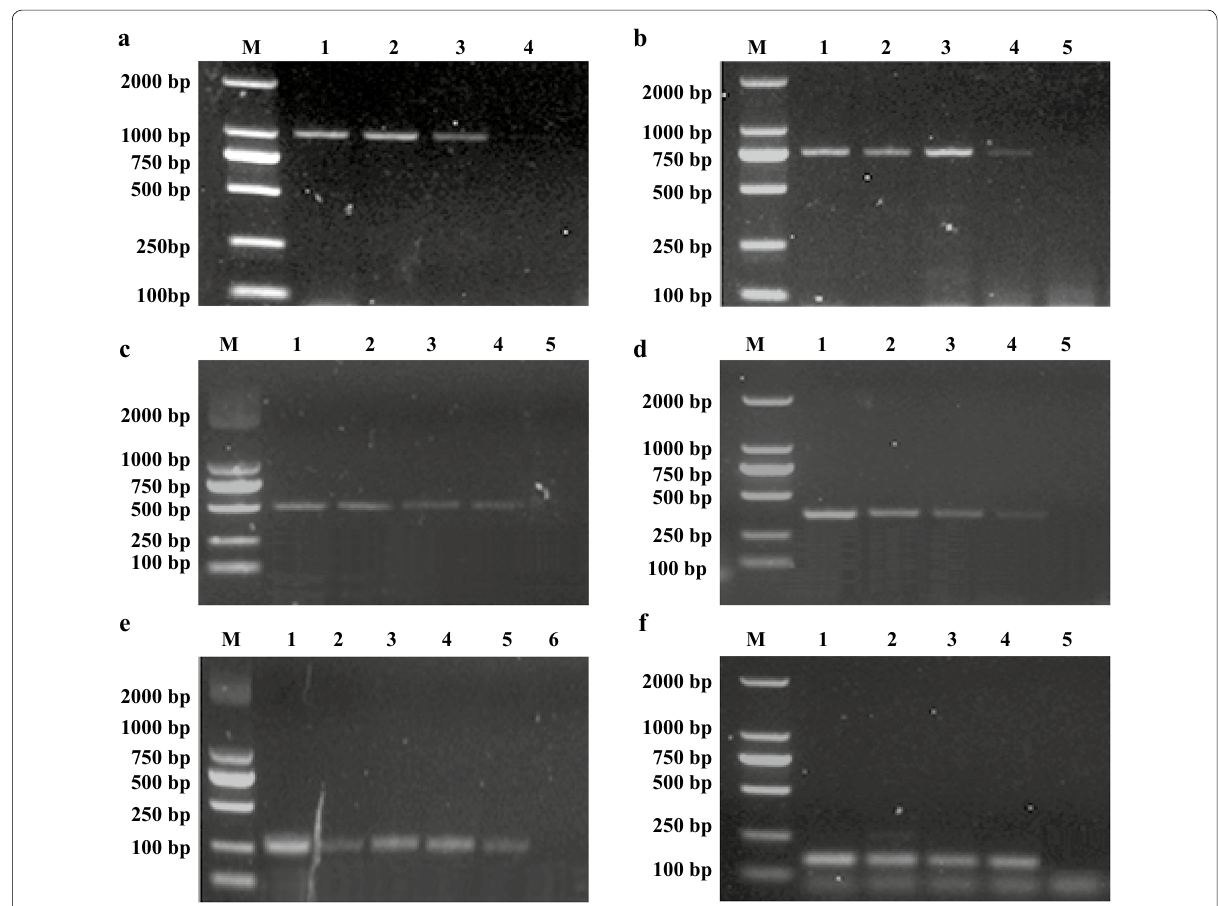
Fig. 6 Determination of the sensitivity of the m-PCR for bacterial CFU detection. Lane M: 2000 bp DNA Marker. a Lanes 1–4: the template of Escherichia coli respectively were 5 10 5 , 5 10 4 , 5 10 3 and 5 10 2 CFU, respectively. b Lanes 1–5: the template of Pasteurella multocid a × × × × respectively were 6 10 6 , 6 10 5 , 6 10 4 , 6 10 3 and 6 10 2 CFU, respectively. c Lanes 1–5: the template of Proteus mirabilis respectively were × × × × × 2.8 10 6 , 2.8 10 5 , 2.8 10 4 , 2.8 10 3 and 2.8 10 2 CFU, respectively. d Lanes 1–5: the template of Pseudomonas aeruginosa respectively were × × × × × 8.6 10 6 , 8.6 10 5 , 8.6 10 4 , 8.6 10 3 , 8.6 10 2 CFU, respectively. e Lanes 1–6: the template of Salmonella spp. respectively were 3.2 × × × × × 3.2